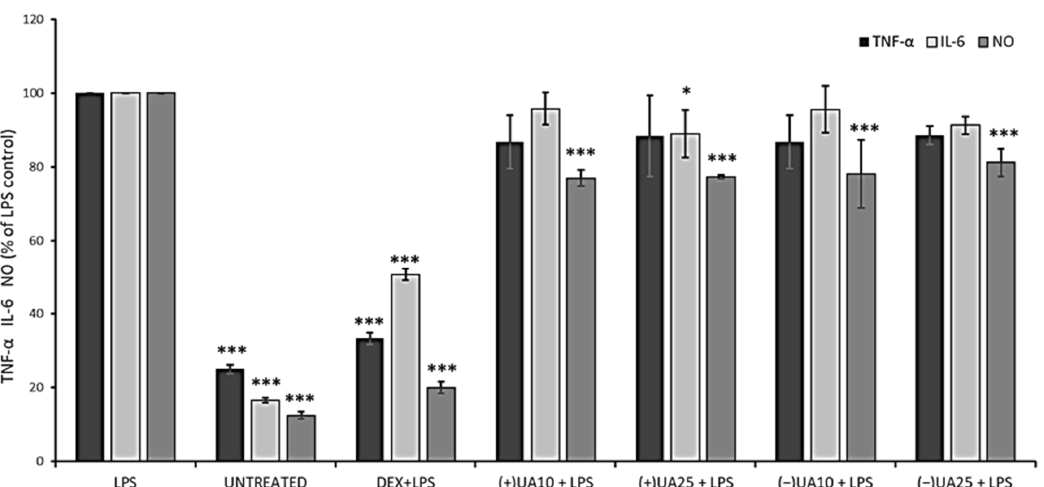
Figure 4. The effect of (+)- and ( − )-usnic acid on tumour necrosis factor-alpha (TNF- α ), interleukin-6 (IL-6) and nitric oxide (NO) release in LPS-stimulated RAW 264.7 macrophages. RAW cells were pre-treated with 10 (UA10) and 25 (UA25) µ g/mL of usnic acid enantiomers for 1 h, afterwards cells were incubated with (10 ng/mL) or without LPS (untreated) for the next 24 h. Dexamethasone (DEX) was used as a reference. Values are presented as the mean ± SD (standard deviation) of three independent experiments in triplicate. Statistical analyses were carried out by using one-way ANOVA and Tukey post-hoc test with * p < 0.05 and *** p < 0.001 against the LPS-stimulated cells.